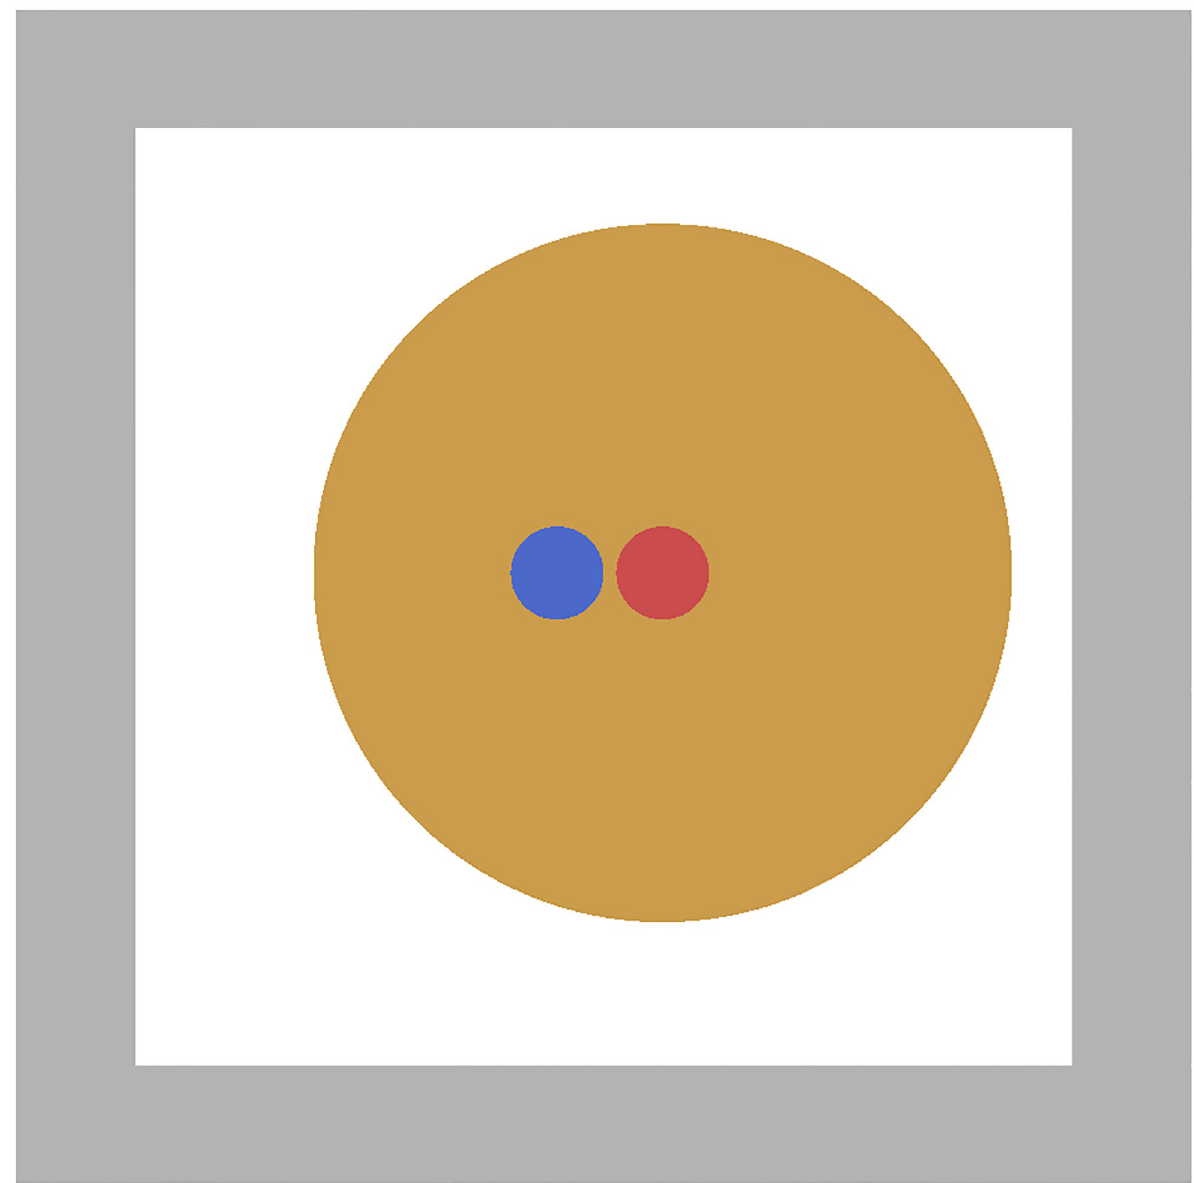
Fig 4. Close contact scenario. A highly infectious virtual person (red) emits pathogens bound to aerosols (orange) in an unventilated enclosed space. A susceptible person (blue) absorbs pathogens.